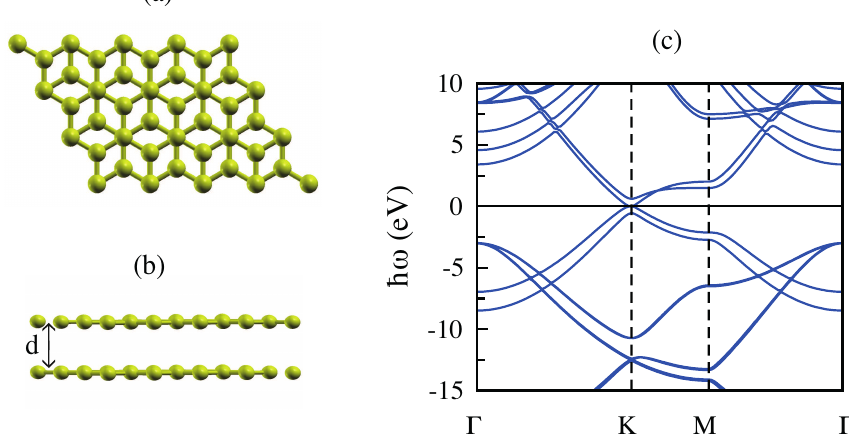
Figure 4. ( a , b ) Top and side view of the atomic structure of bilayer graphene (BLG). ( c ) The band structure of BLG along the high symmetry Γ − K − M − Γ directions in reciprocal space. The optimized interplane distance ( d ) is calculated to be 3.45